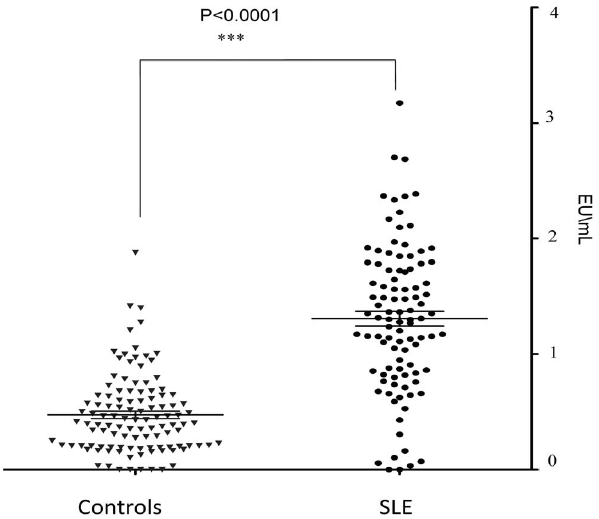
Figure 5. SLE patient circulating endotoxin levels. Circulating endotoxin was quantitated using the Limulus assay. 99 female SLE patients and 112 female Red Cross blood donors were anlayzed. SLE patients had significantly more endotoxin on average than controls (P , 0.0001). The cross bars indicate the mean and standard error.